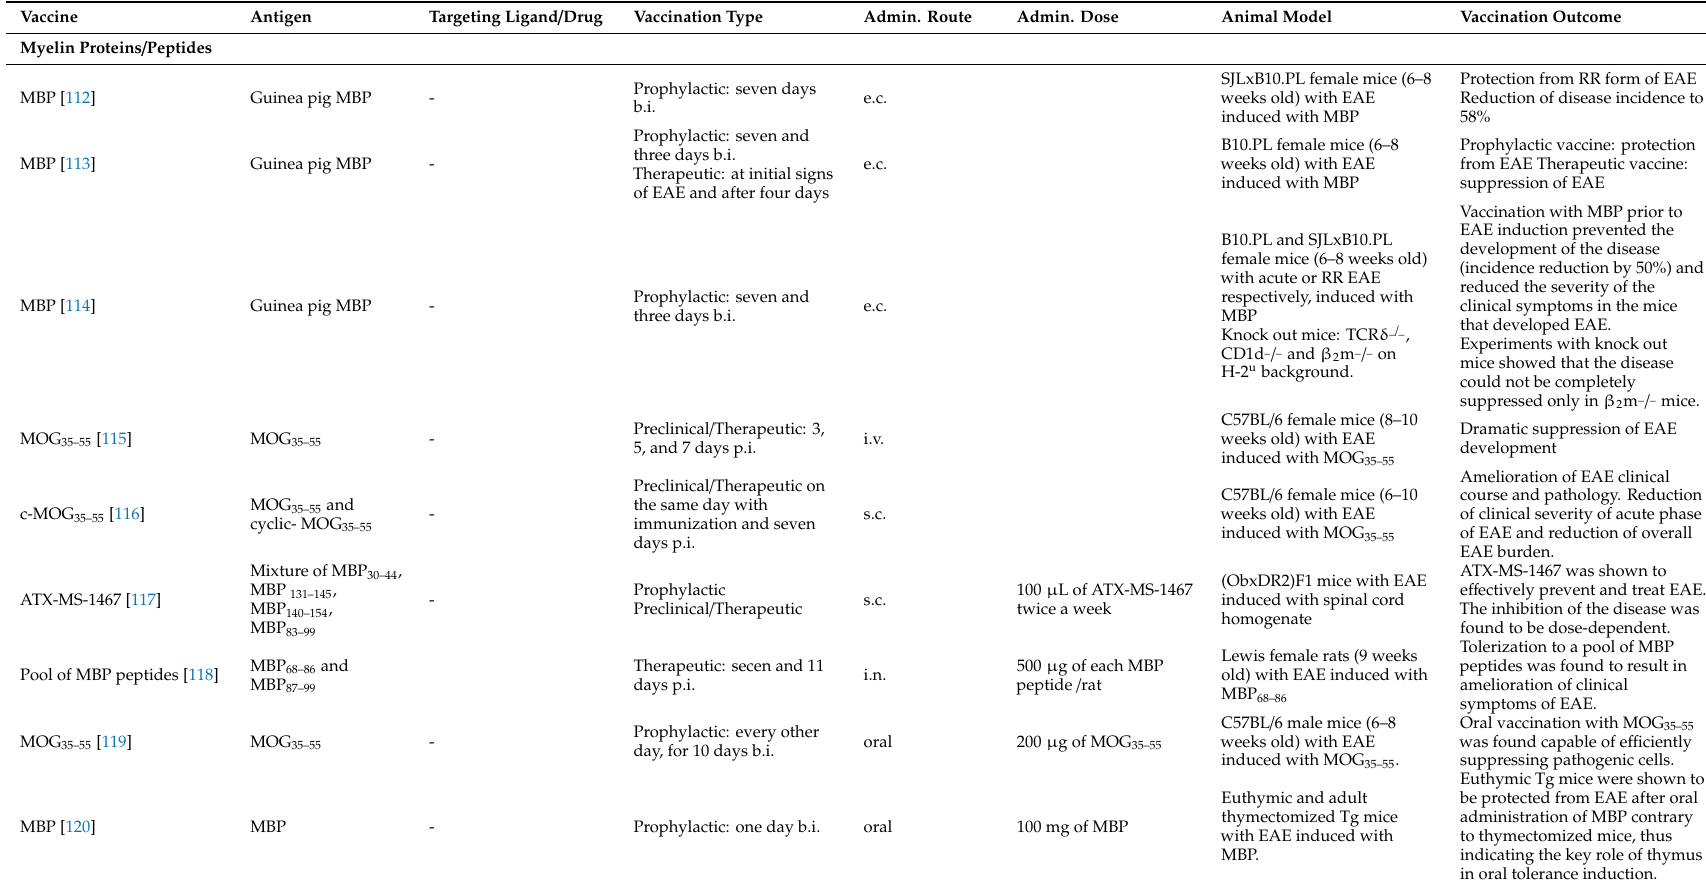
Table 2. Myelin protein / peptide-based